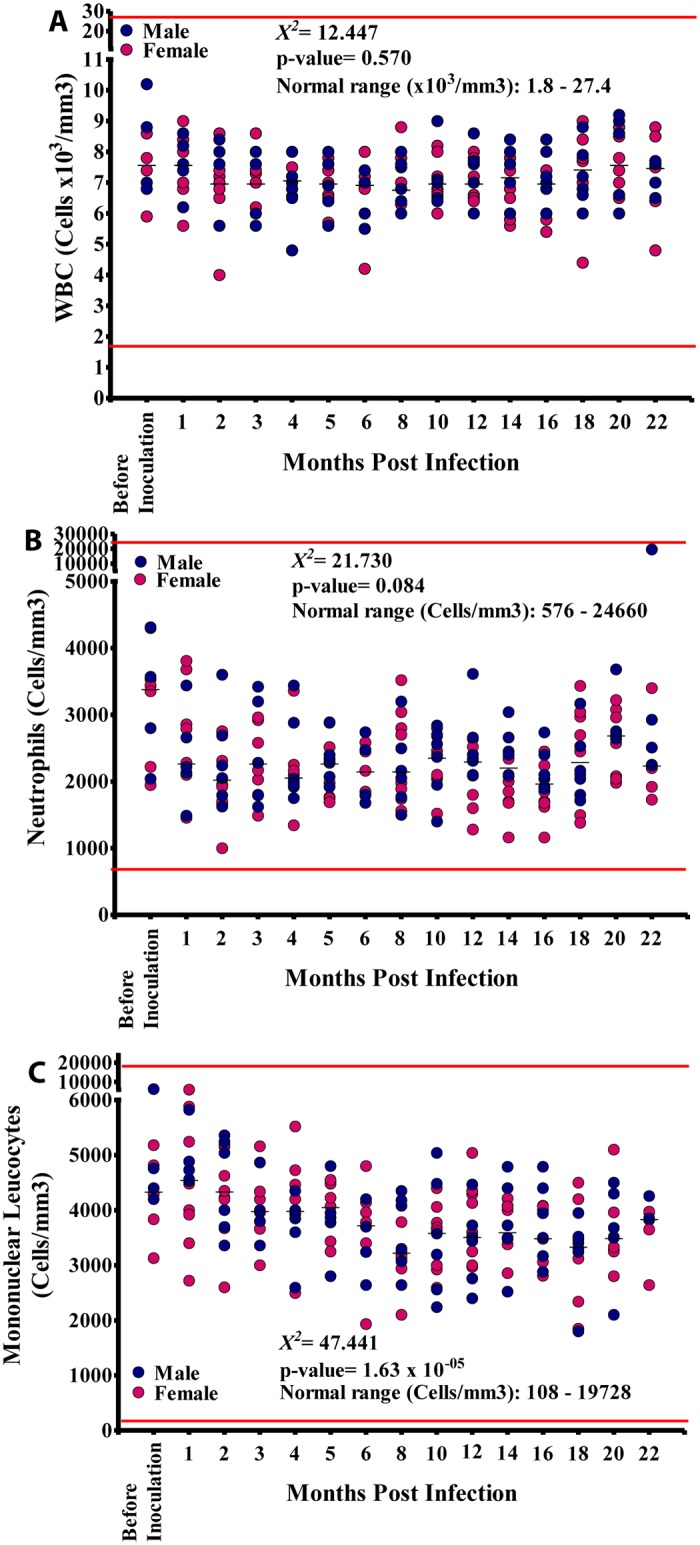
White blood cell (WBC) counts during infection.A. Total WBC. B. Absolute neutrophil counts. C. Absolute mononuclear (monocyte and lymphocyte) counts.